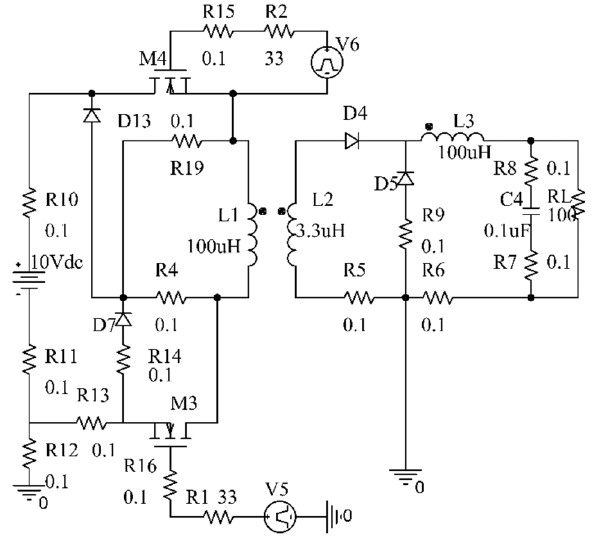
Figure 5. Two-switch forward convertor